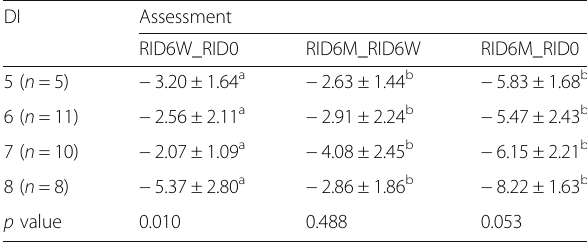
Table 5 Descriptive data for differences recorded between RBH values as bone gains and losses between assessments ( n = 34)